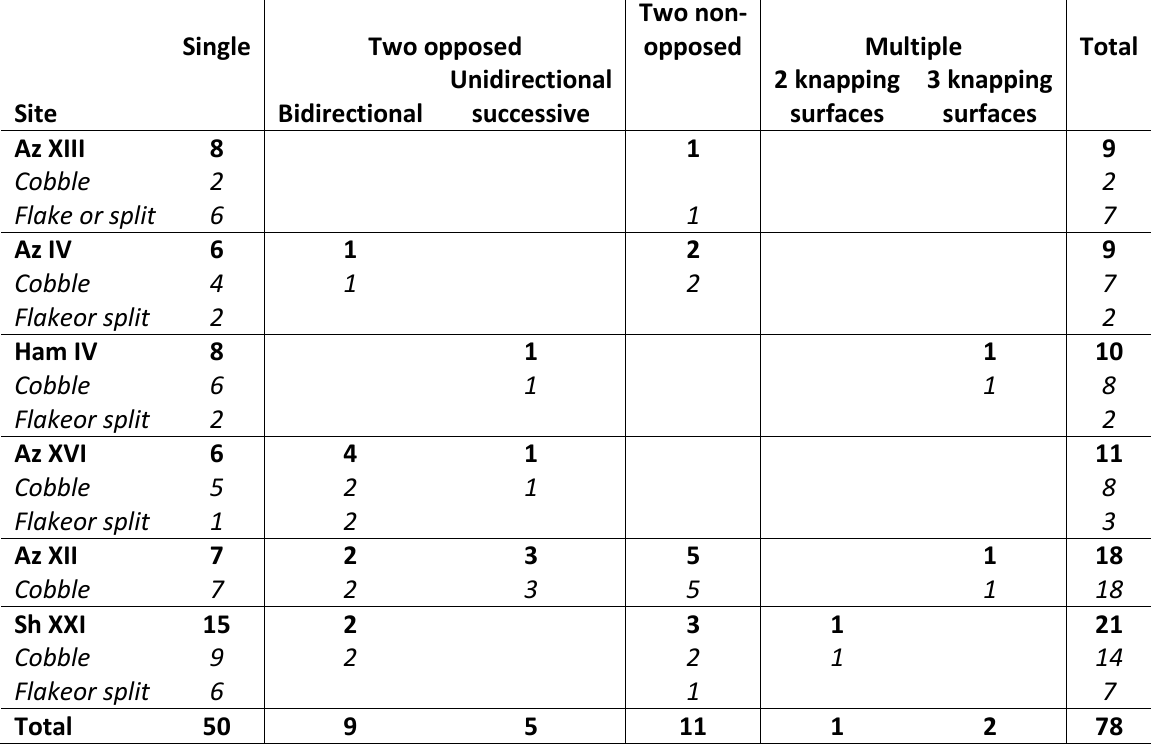
Two non- opposed Multiple Total Unidirectional 2 knapping 3 knapping successive surfaces